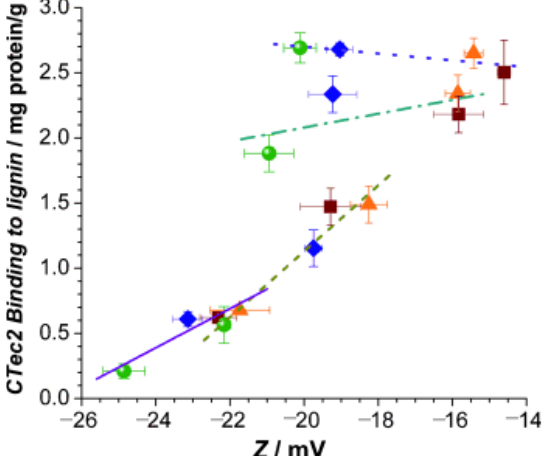
Figure 4. Correlations between lignin surface charge (Zeta potential, Z) and nonspecific CTec2 binding to the four hydrolysis lignin residues at different pH. ▪ DA; ▴ SP-B2; ⧫ SP-B4; • SP-B6; pH 4.5 y = − 0.026x + 2.18, r 2 = 0.65; pH 4.8 y = 0.053x + 3.14, r 2 = 0.40; pH 5.5 y = 0.253x + 6.19, r 2 = 0.94; pH 6.0 y = 0.150x + 3.99, r 2 = 0.90; adapted from [52].